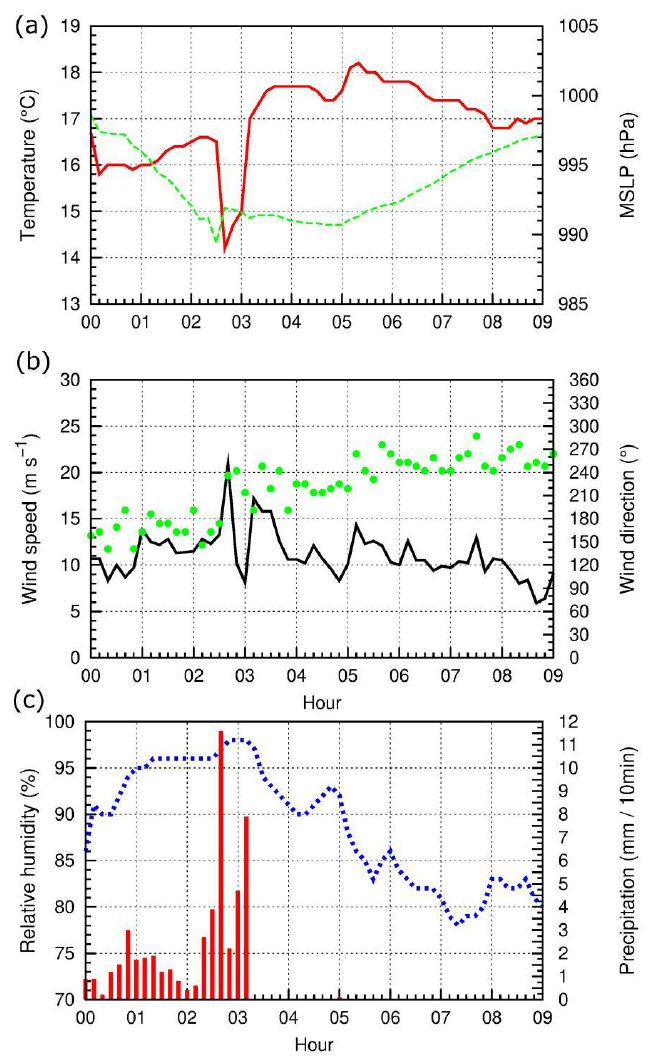
Figure 9. Time evolution of ( a ) 2-m temperature (red line) and MSLP, ( b ) wind gust (black line) and wind direction at 10 m, and ( c ) relative humidity (blue dashed line) and 10-min accumulated precipitation at the station of Portimão (see its location in Figures 1d and 7c).